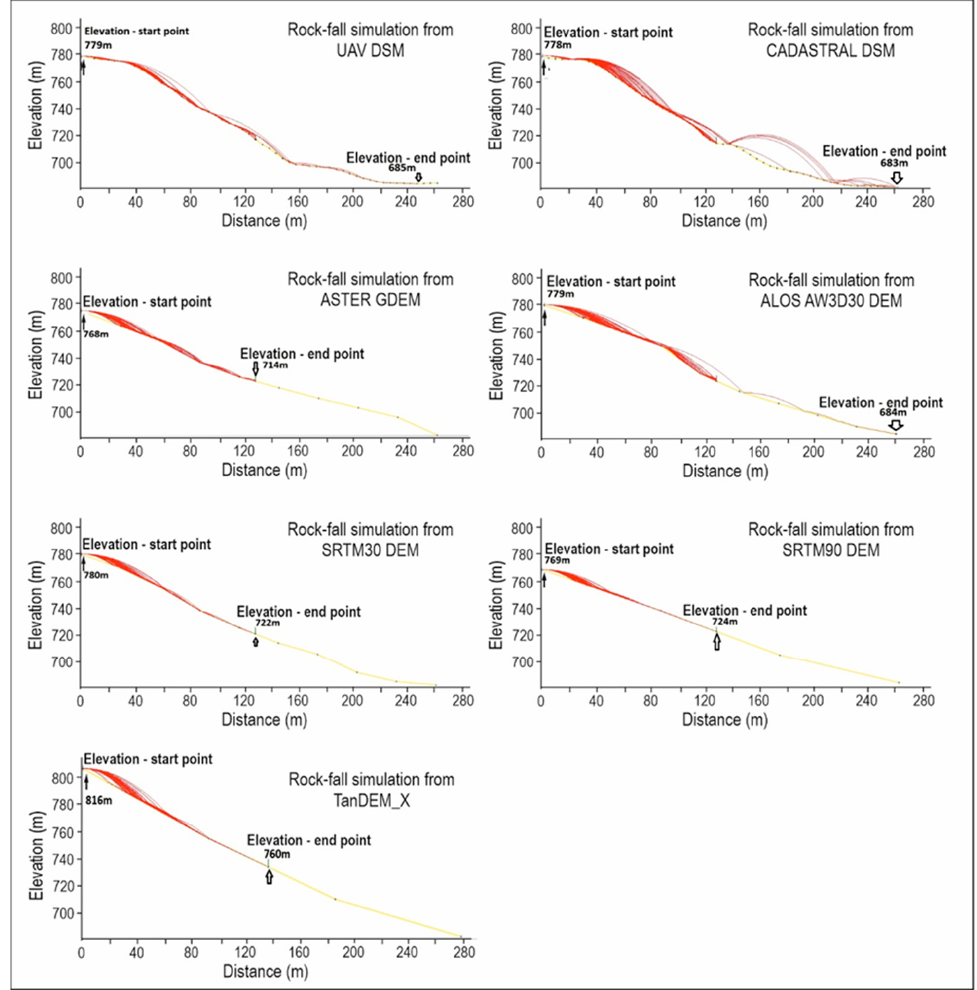
Figure 11. Two-dimensional rockfall simulations via RocFall software for the 2nd slope profile.